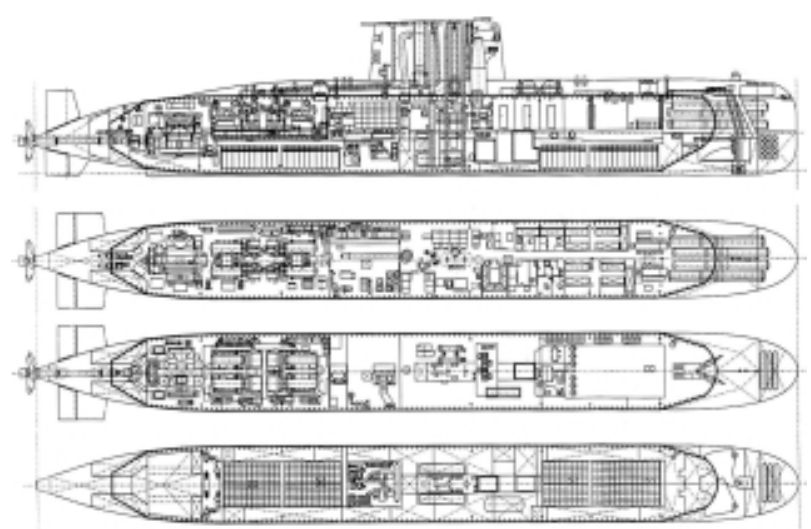
Fig. 2. General arrangement of the U209-1400